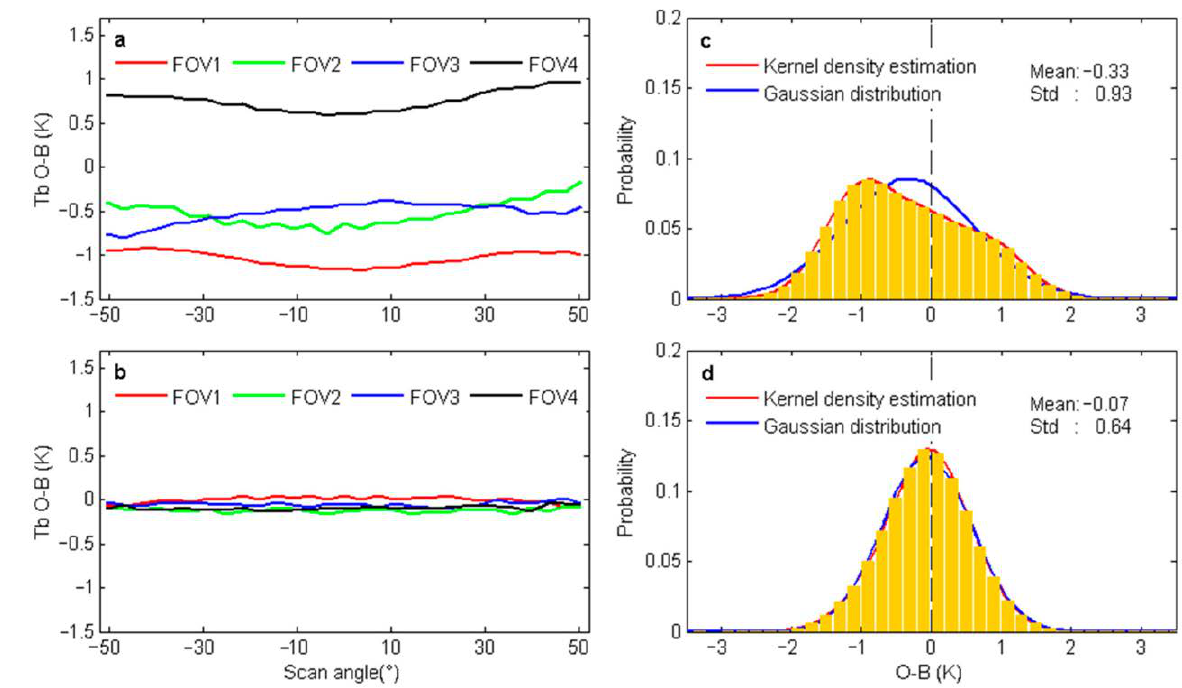
Figure 7. The mean variation of biases with a scan angle of four FOVs ( a , c ), and the probability density distribution of biases at 688.125 cm − 1 ( b , d ) before and after bias